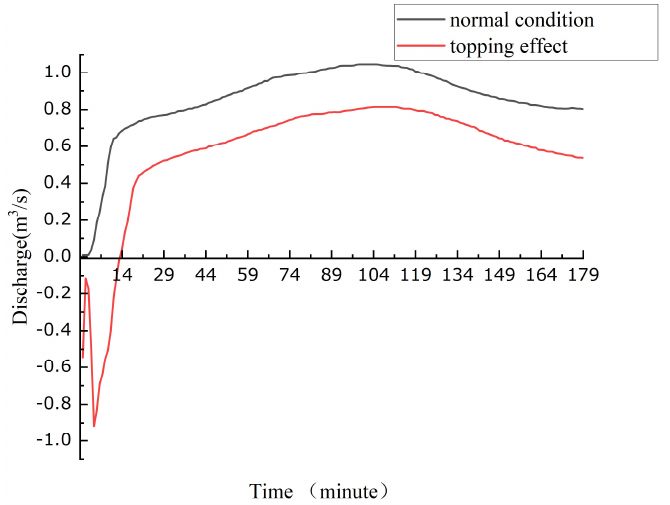
Figure 12. Comparison of discharge flow at the Taiqing Road outfall before and after the water level rises under condition D.